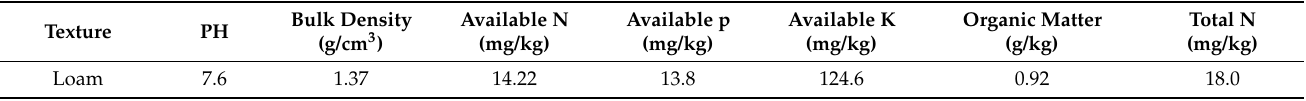
Table 4. The soil texture